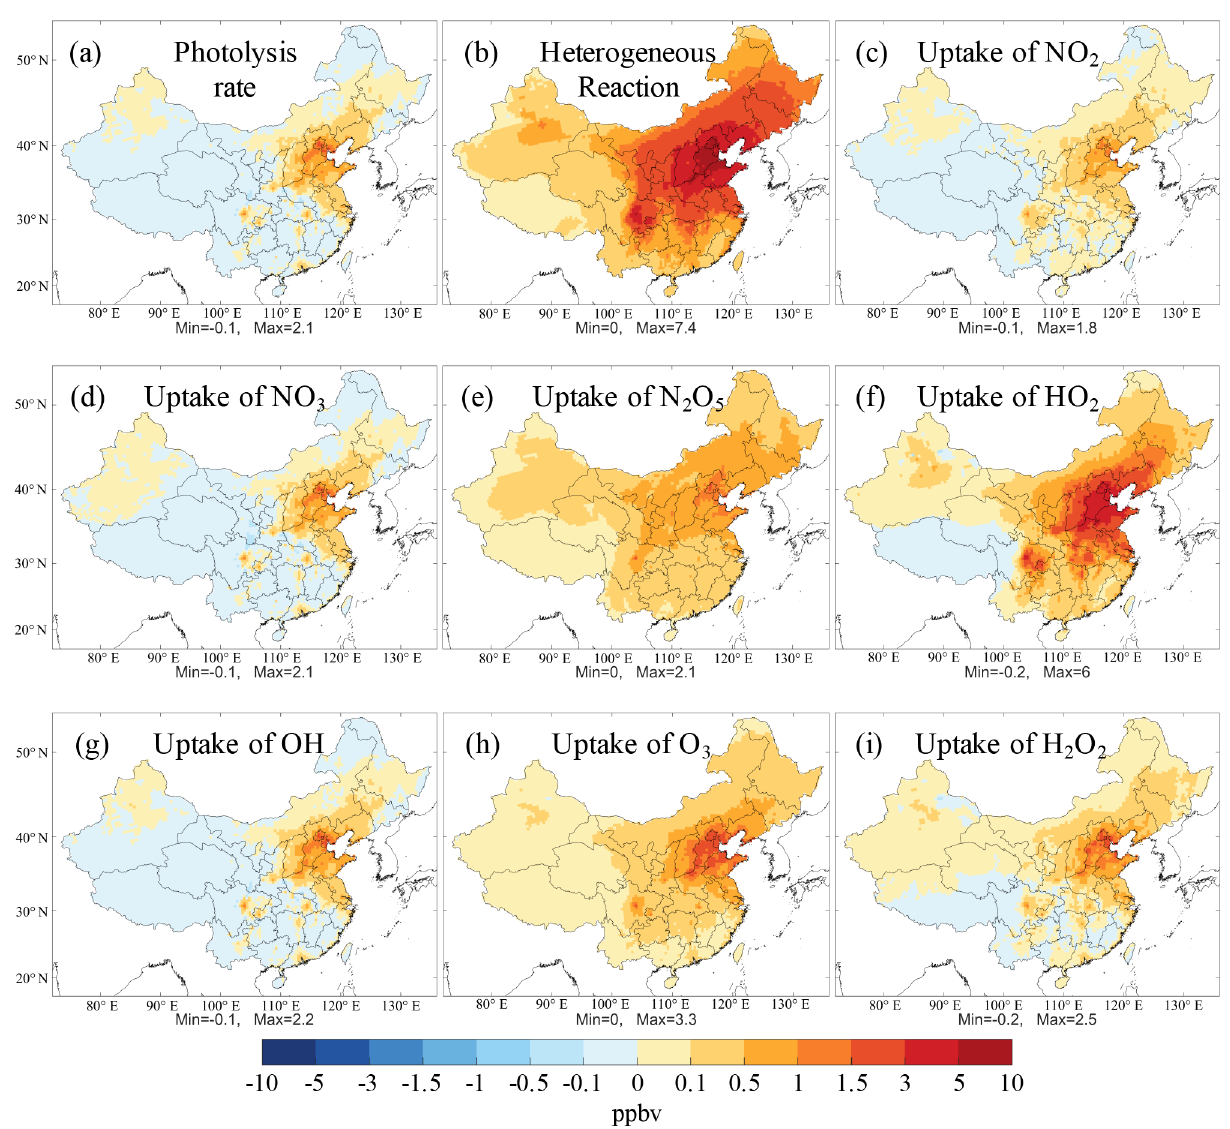
Figure 5. Spatial distribution of the simulated MDA8 O 3 mixing ratios responding to the changes in the effects of aerosol in summer from 2013 to 2017 (see Methods section). The aerosol affects O 3 via altering (a) photolysis rates, (b) all heterogeneous reactions, and individual heterogeneous reactions, namely the uptake of (c) NO 2 , (d) NO 3 , (e) N 2 O 5 , (f) HO 2 , (g) OH, (h) O 3 , and (i) H 2 O 2